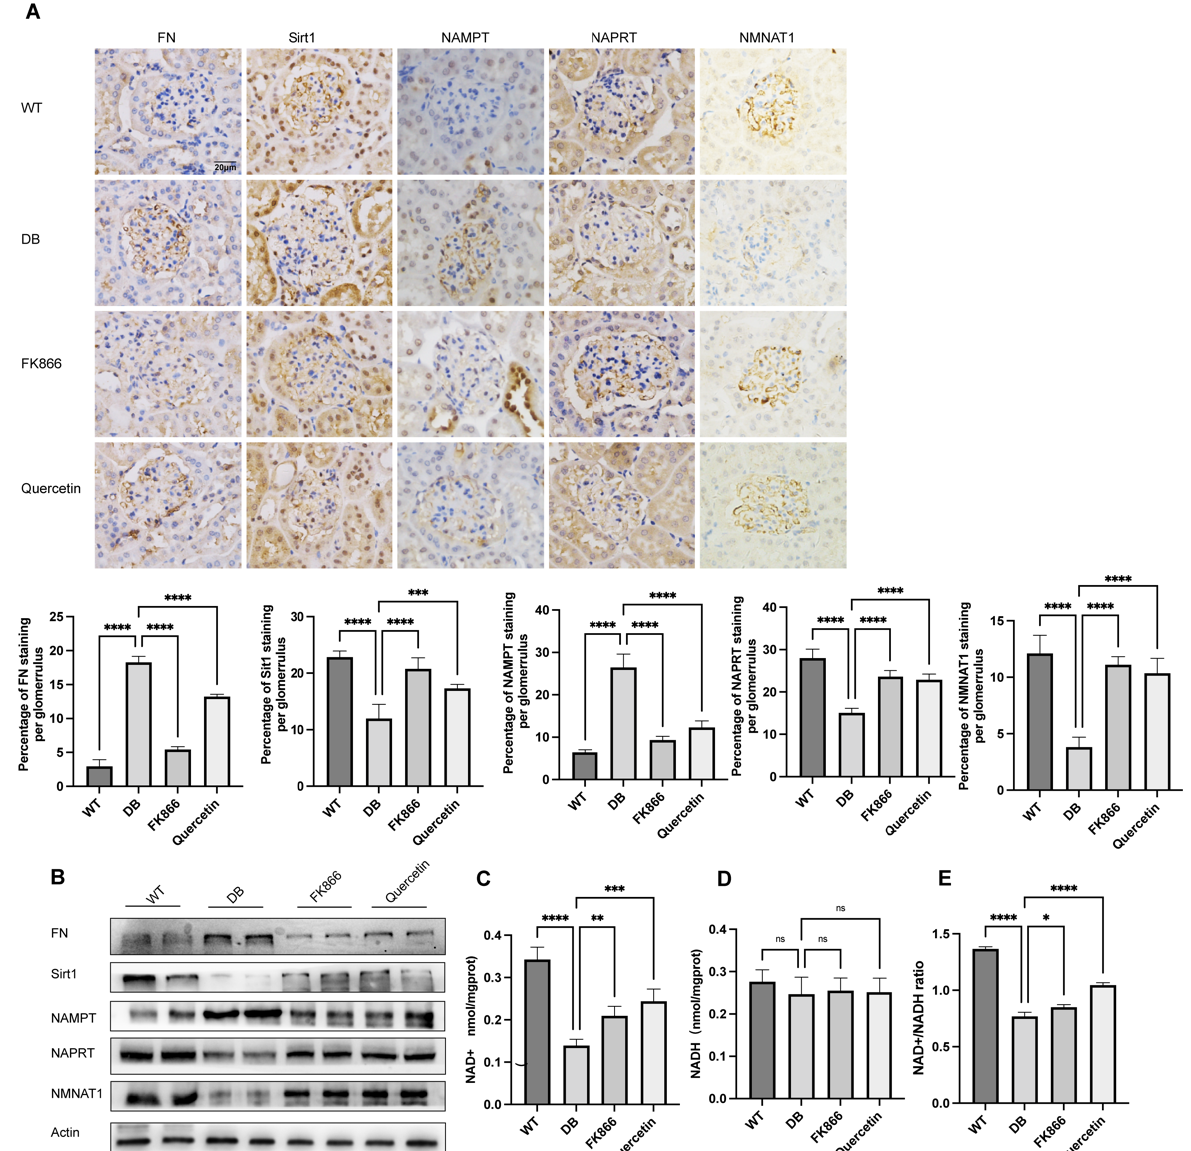
Figure 5. FK866 and quercetin effects on NAD + -related enzymes and fibrotic maker expression in mice: ( A ) Representative of immunohistochemical of mice renal tissues for FN, Sirt1, NAMPT, NAPRT, and NMNAT1; 20 × 10 magnification; scale bar = 20 µ m; data represent mean ± SD. Western blot analysis of FN, Sirt1, NAMPT, NAPRT, and NMNAT1 expression from renal tissues protein of mice ( B ). β -actin served as a loading control and the statistic based on the densitometric quantification of bands. NAD + ( C ), NADH ( D ), and NAD + /NADH ratio ( E ) were measured in renal tissues from separated group mice; n = 3 independent samples; data represent mean ± SD; ns means no significance, * p ≤ 0.01, ** p < 0.01, *** p < 0.001, **** p < 0.0001.